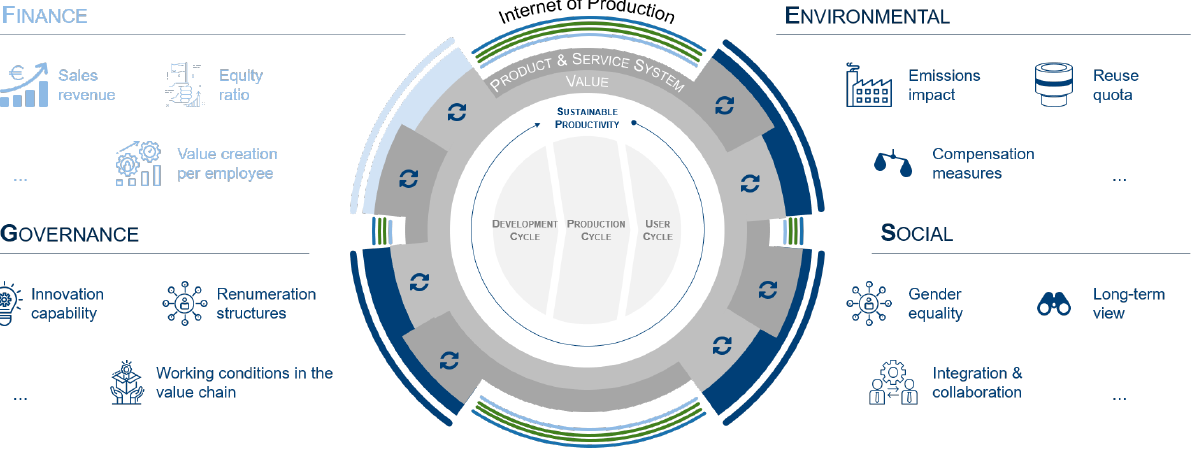
Figure 6. An illustration of sustainable resilient manufacturing [33]. © WZL—RWTH